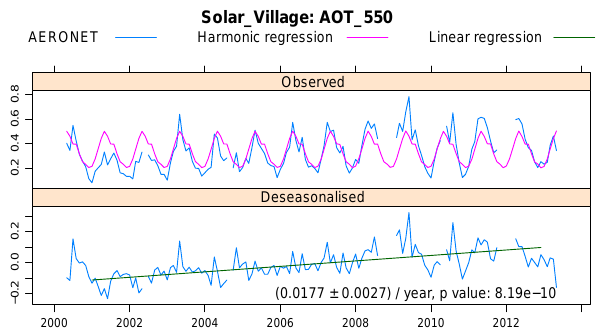
Figure 4. Evolution of the AOD measured by the AERONET sta- tion Solar Village. The measurements have been linearly interpo- lated to 550nm wavelength. Deseasonalisation and trend analysis are performed as for Fig. 3; see also Figs. S33 and S34 in the Sup- plement.